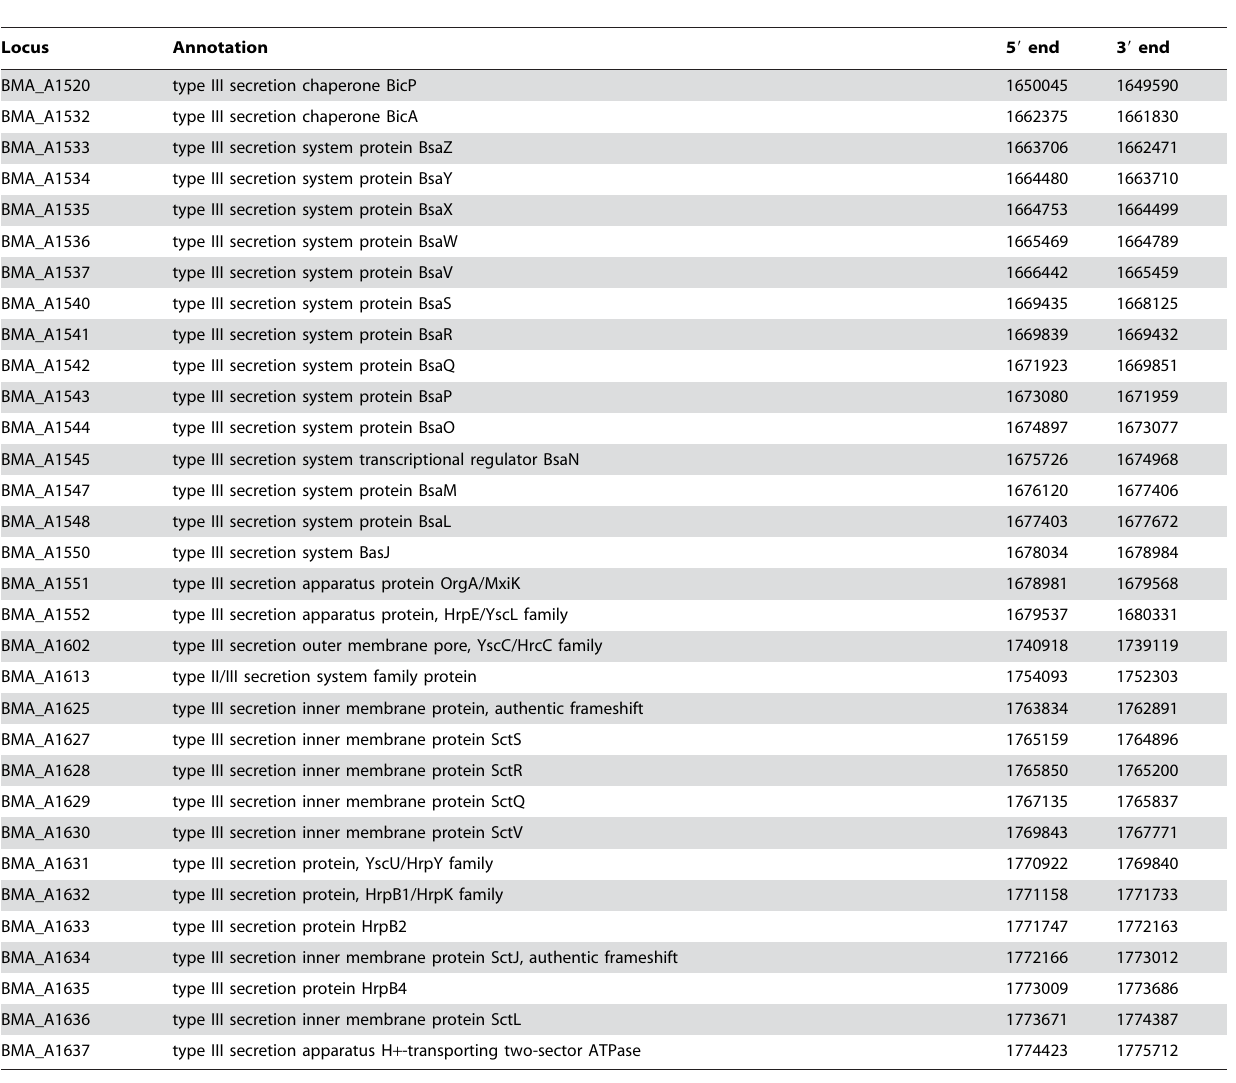
Table 1. Type III secretion proteins encoded by genes present in ATCC 23344 but absent in SAVP1.